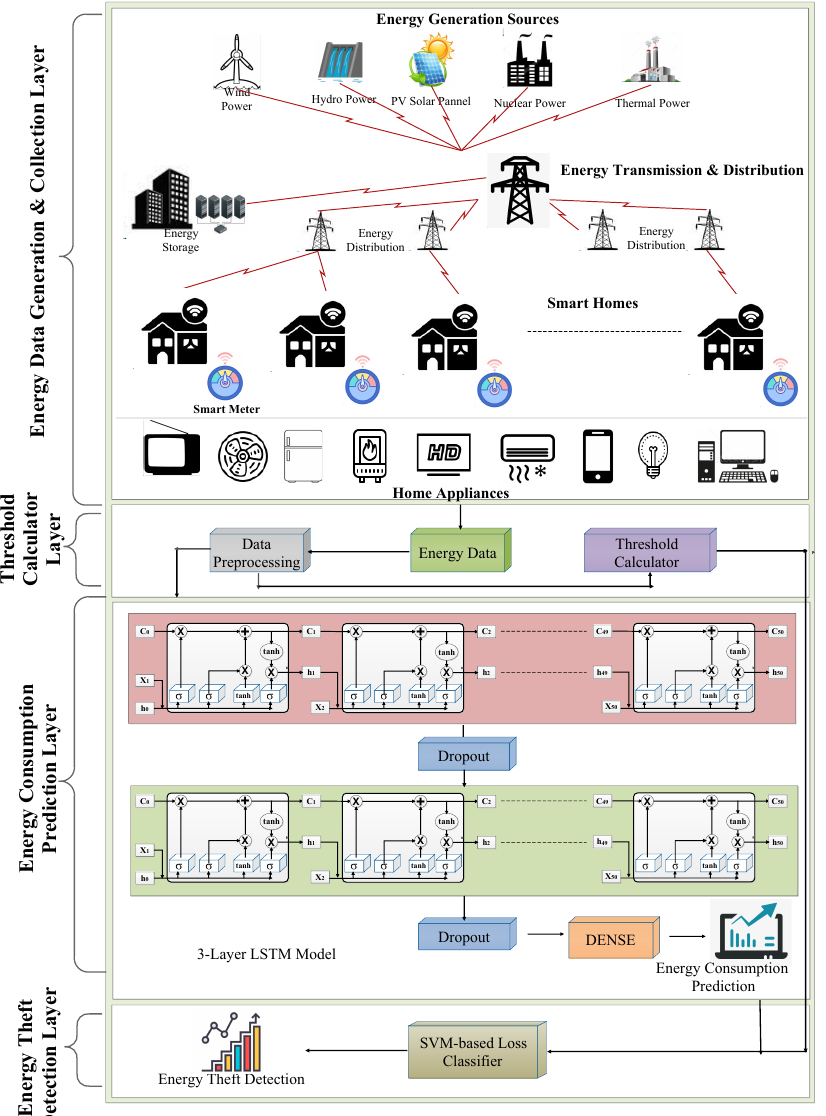
Figure 4. GrAb system